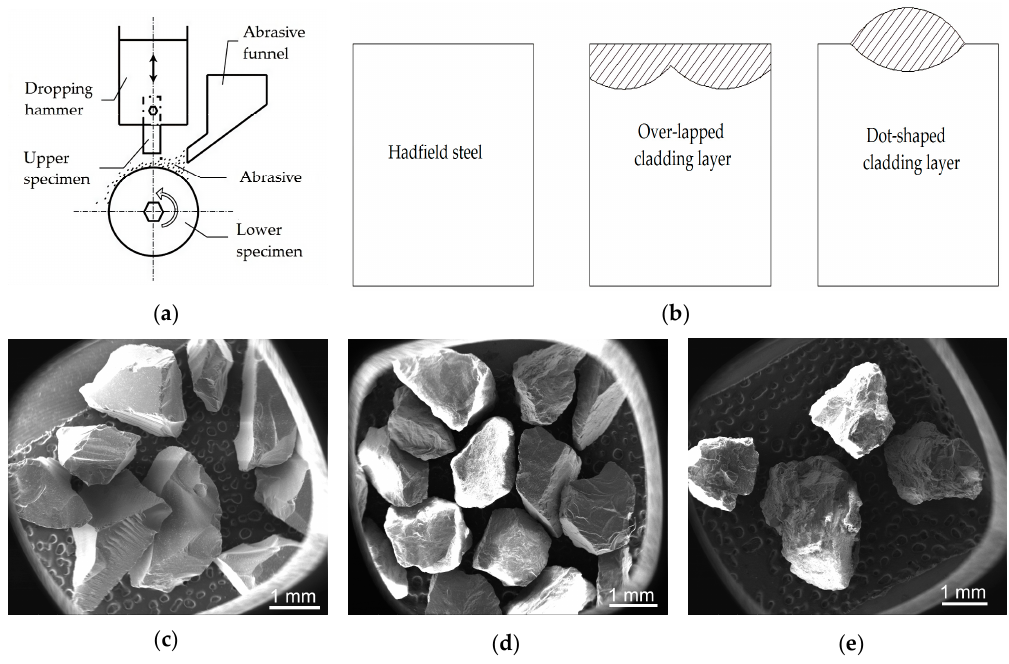
Figure 4. Impact abrasive wear test: ( a ) The schematic of the MLD-10 impact abrasive wear tester; ( b ) The schematics of the upper specimens; SEM images of ( c ) The glass sand; ( d ) The granite; ( e ) The quartz sand.